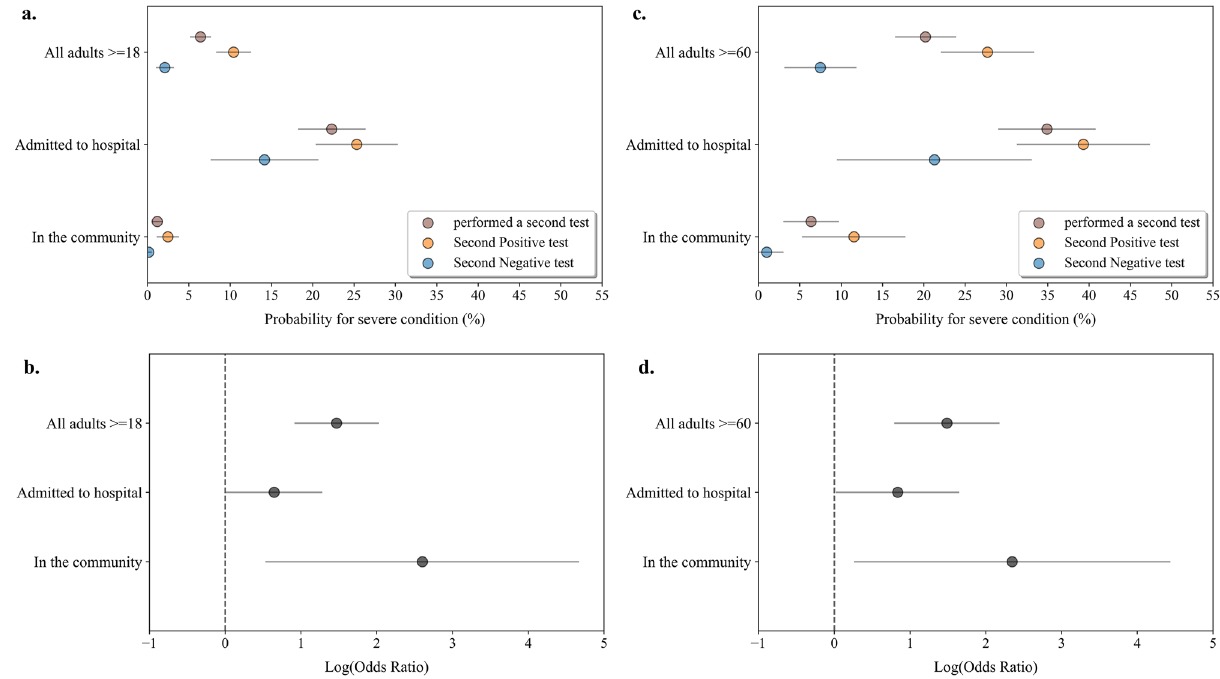
Figure 2. Probability analysis for COVID-19 deterioration following a second NP SARS-CoV-2 PCR test in different clinical settings. ( a ) Probability of infected adults (>=18 years old), tested a second time within the first week following diagnosis in the hospital and in the community, to deteriorate to severe COVID-19. Brown circles represent individuals with a second test a week following diagnosis, blue circles represent individuals who tested negative, orange circles represent individuals who tested positive. Grey lines indicate 95% confidence intervals. ( b ) Log odds ratio (OR) for severe COVID-19 was calculated by the result of a second PCR test taken a week following diagnosis in the hospital and in the community. OR > 0 indicated larger risk in the population that tested positive compared to the population tested negative. Calculated log odds ratios are presented along with gray lines indicating 95% confidence intervals. ( c ) Probability analysis for individuals ≥ 60 years old. ( d ) Log odds ratio (OR) for severe COVID-19 for individuals ≥ 60 years